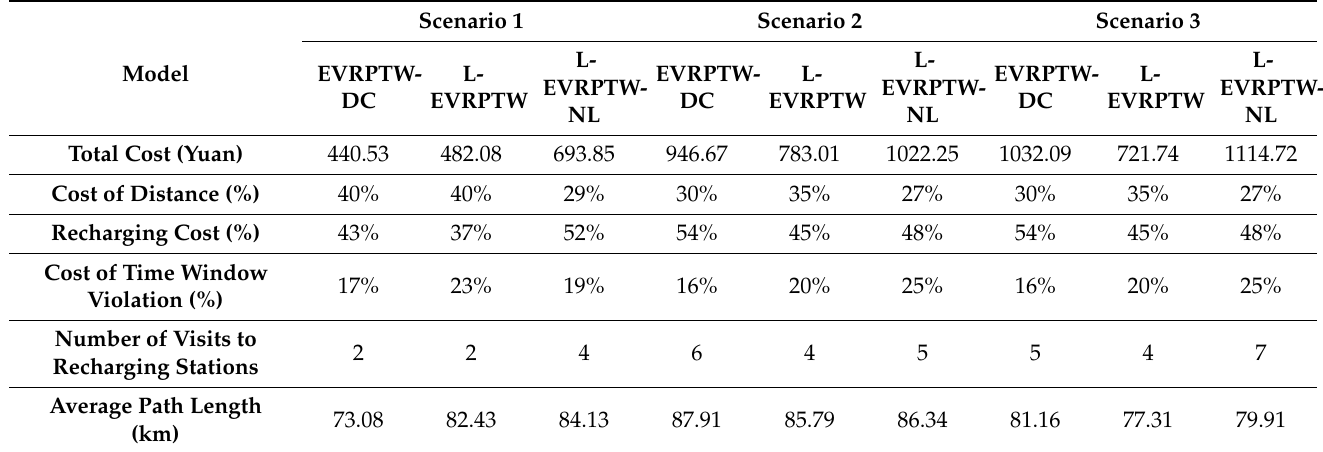
Table 16. Cost compositions of EVRPTW-DC, L-EVVRPTW, and